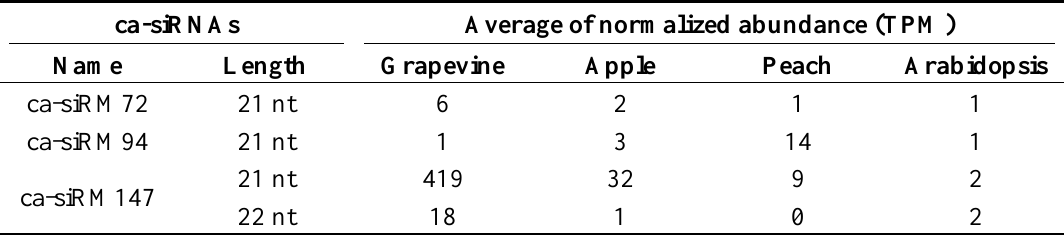
Table 3. Conservation of ca-siRNAs in the sRNA datasets of four